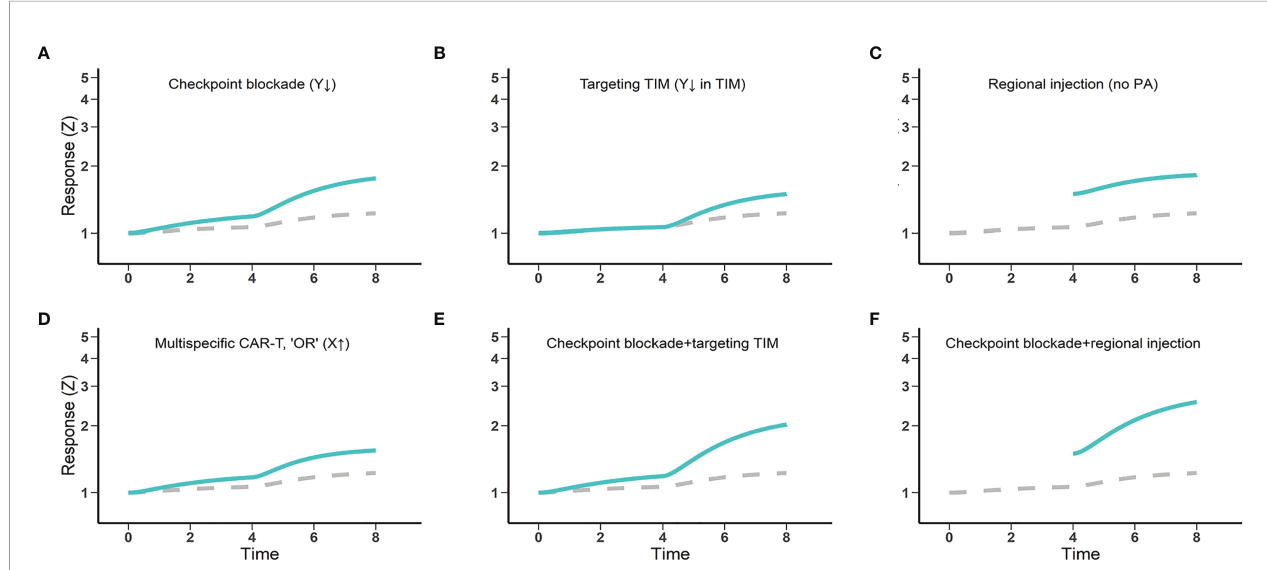
FIGURE 4 | The potential and limitations of several engineering and therapeutic strategies for enhanced CAR-T cell ef fi cacy against solid tumors. Gray dashed lines, CAR-T cell therapy control; Blue lines, CAR-T cell therapy combined with other strategies (A, B, E, F) , regionally administered CAR-T cells (C, F) , and multi-speci fi c CAR-T cells (D) . Response (Z) generally indicates the magnitude of CAR-T cell activation and functions, including cytokine production potential and cytotoxic